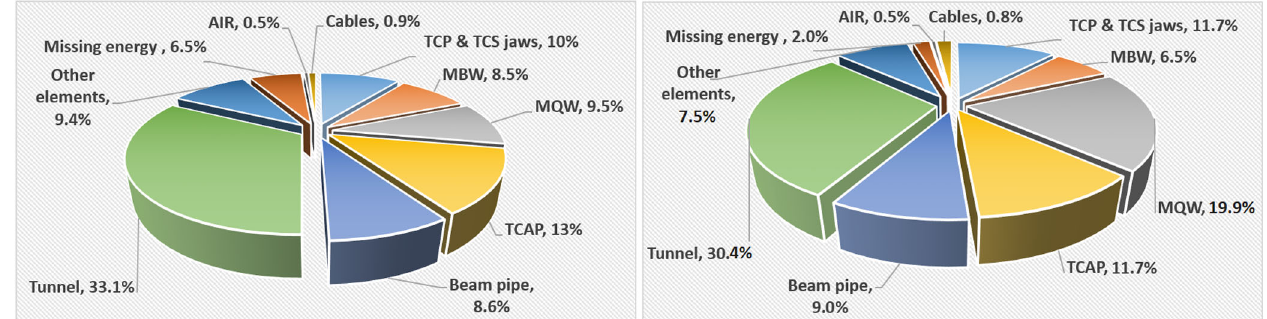
2. Power percentages on different LSS elements for LHC at 6.5 TeV (left) and HE-LHC at 13.5 TeV (right) beam energy. Missing energy indicates the energy converted to mass as well as the energy carried away by neutrinos.